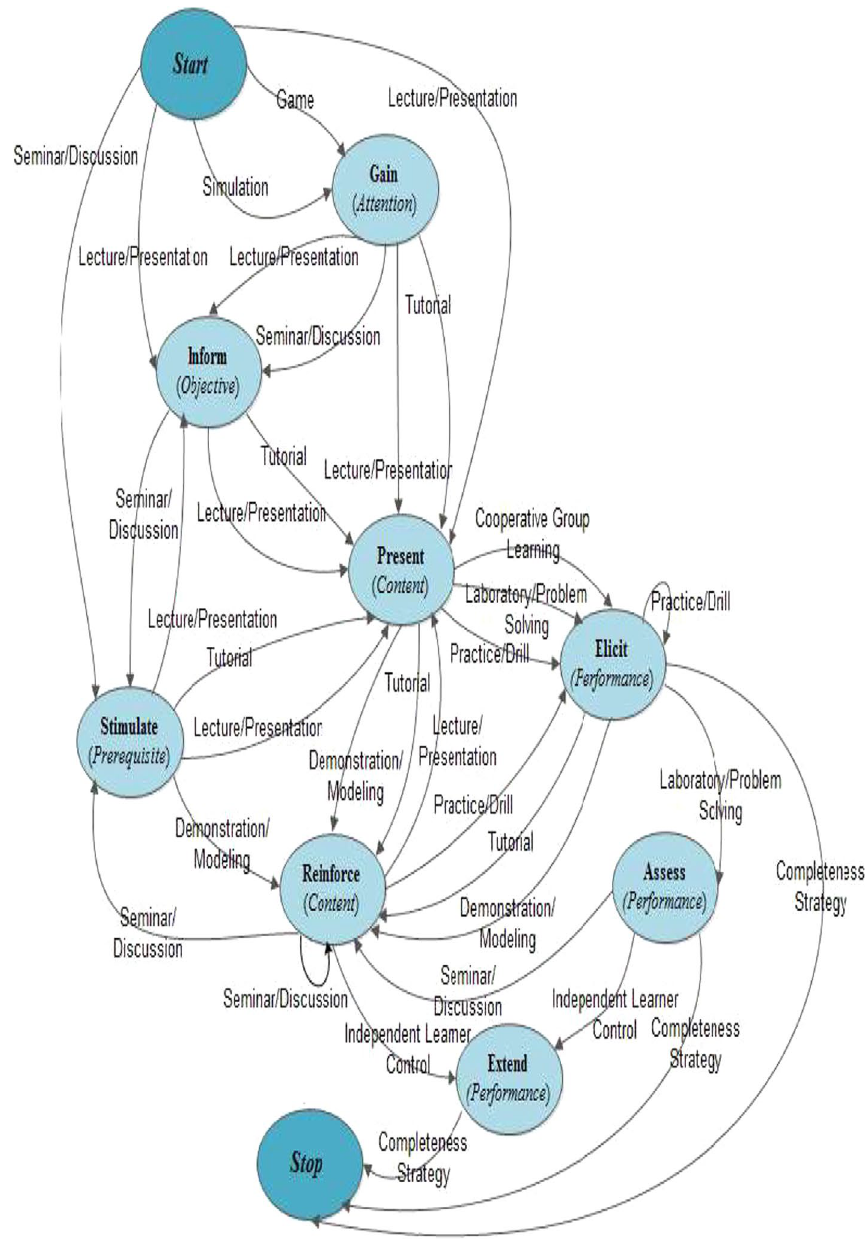
Fig. 1 Pedagogical process model (Saâdi et al.,